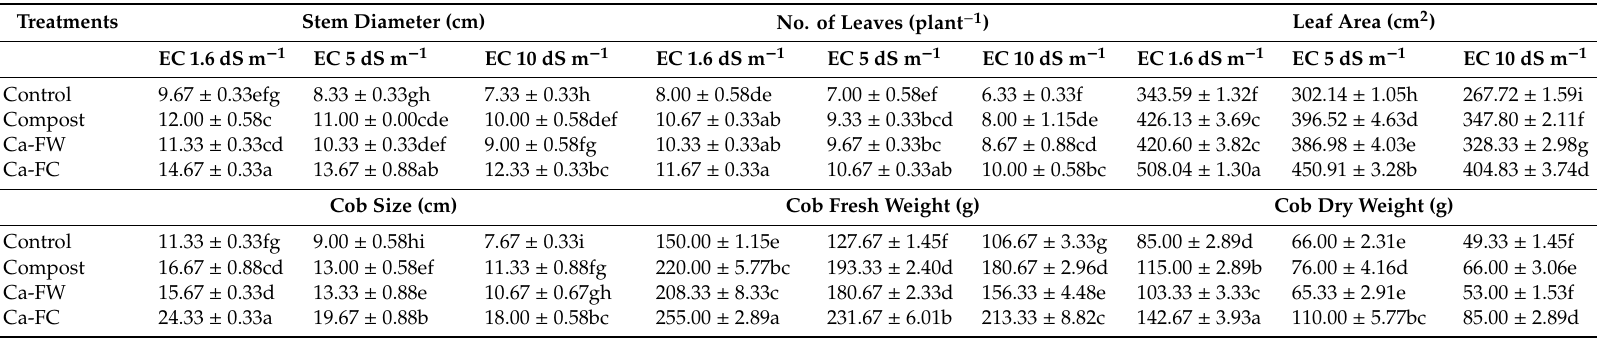
Table 1. E ff ect of compost, Ca-FW, and Ca-FC on growth and yield parameters of maize ( Zea mays L.) under saline–sodic soil conditions.